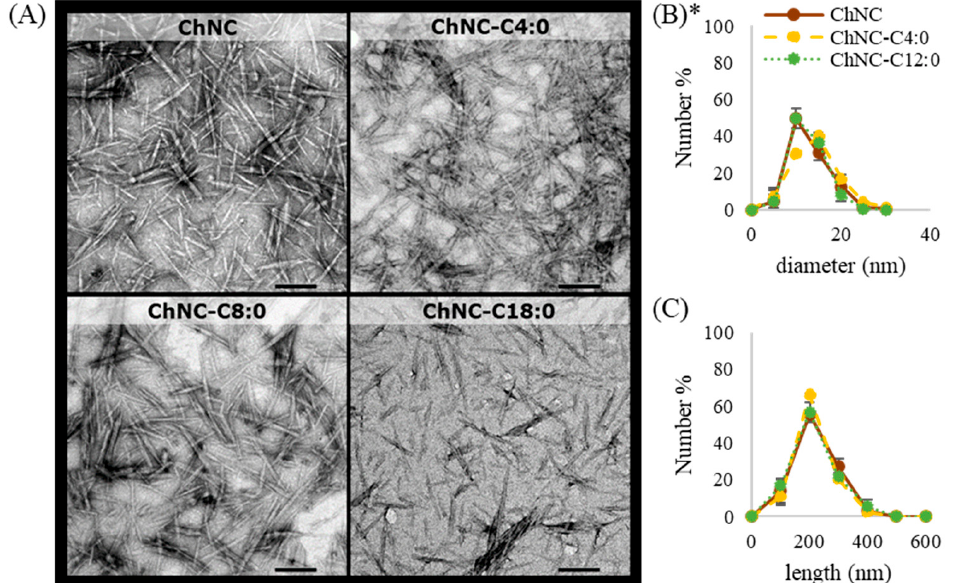
Figure 1. ( A ) Transmission electron microscopy images of ChNC as such and ChNC modified with C4:0, C8. ( B ) The particle diameter and ( C ) particle length distribution determined from TEM images. The error bars represent the standard deviation of three different regions; a total of 50 particles were measured per region. * It was not possible to determine the particle diameter and length of ChNC-C18:0 due to lower resolution of the pictures of this sample. By eye, this sample looked similar to the other three.